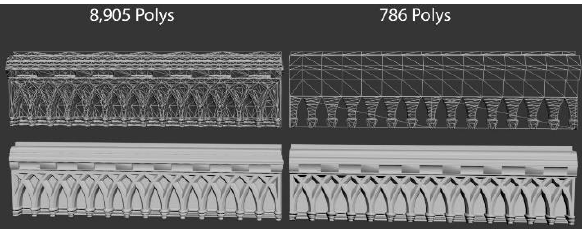
Figure 9. Comparison of a detail element with normal